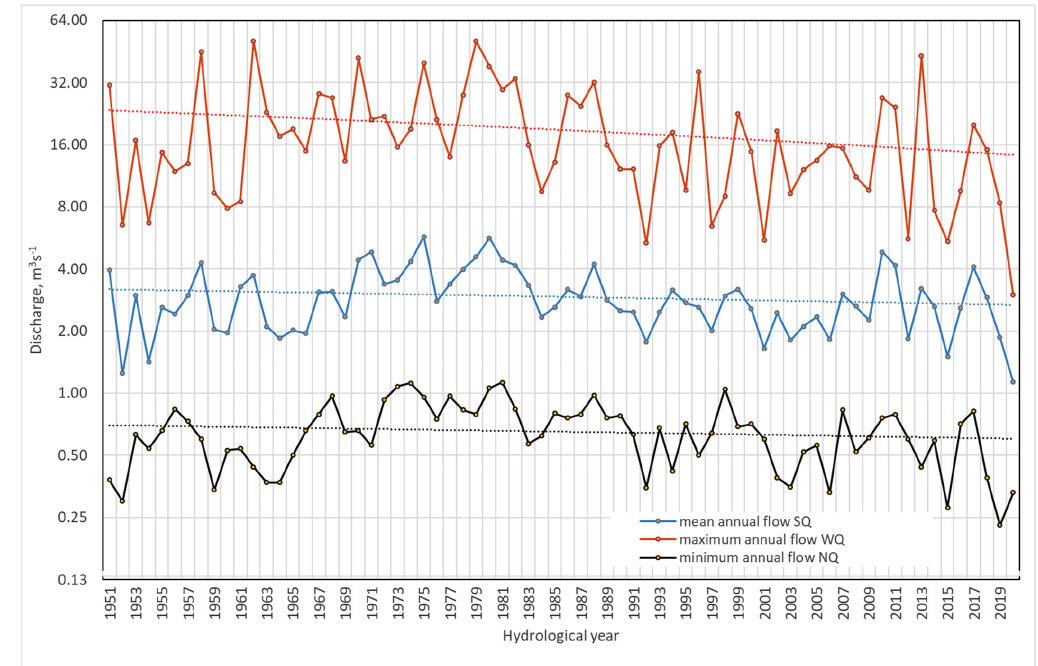
Figure 9. The minimum (NQ), maximum (WQ), and mean (SQ) annual flows (m 3 s − 1 ) in the period of 1951–2020 at the Narewka gauging station.